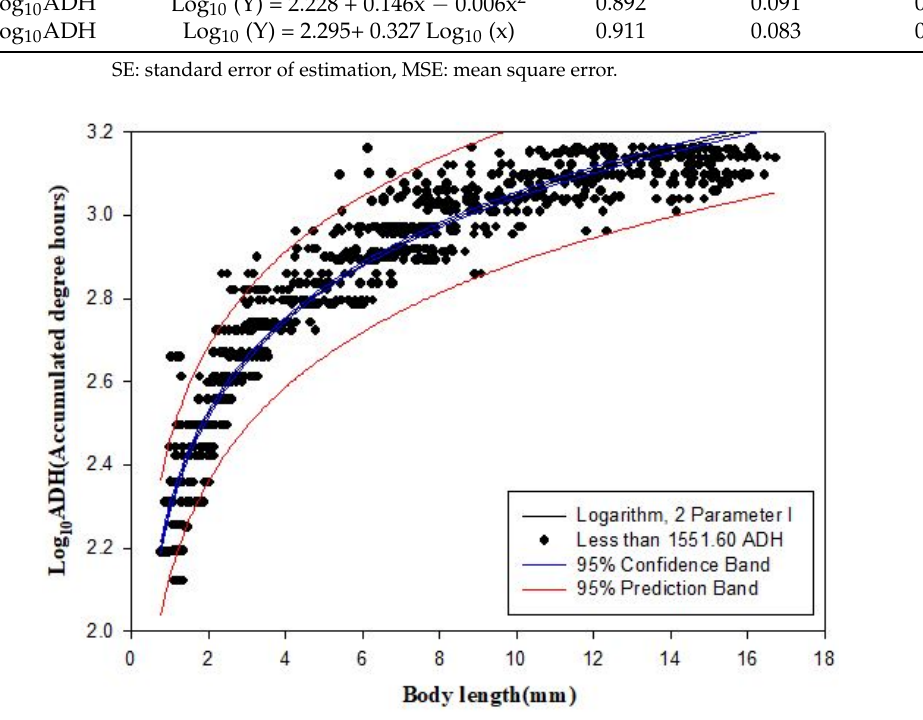
Figure 6. A nonlinear regression analysis was performed from the scatter plot ( n = 973) of feeding larval stages ( ≤ 1551.60 ADH) of Lucilia sericata to determine the correlation between ADH values and body lengths. The adjusted R 2 value and mean square error were 0.911 and 0.007,